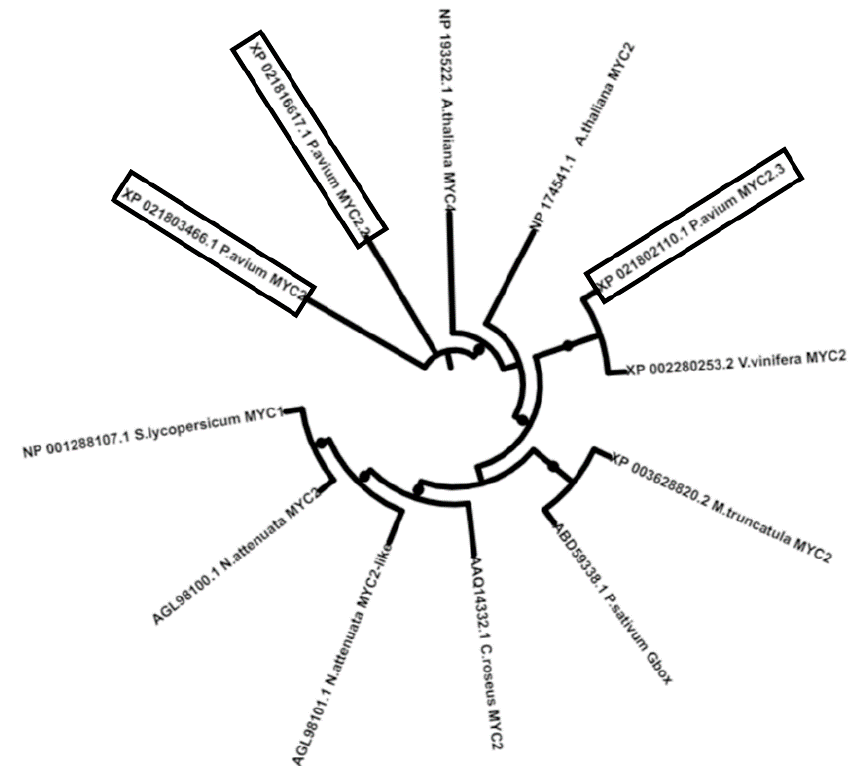
Figure 2. Unrooted maximum likelihood phylogenetic tree (number of bootstraps in ultrafast mode: 1000) of different MYC2 protein’s full length sequences from P. avium (boxed) and other species taken from [23]. Bootstrap values comprised of between 0.8 and 1 are displayed (the bigger the circle, the higher the bootstrap value).